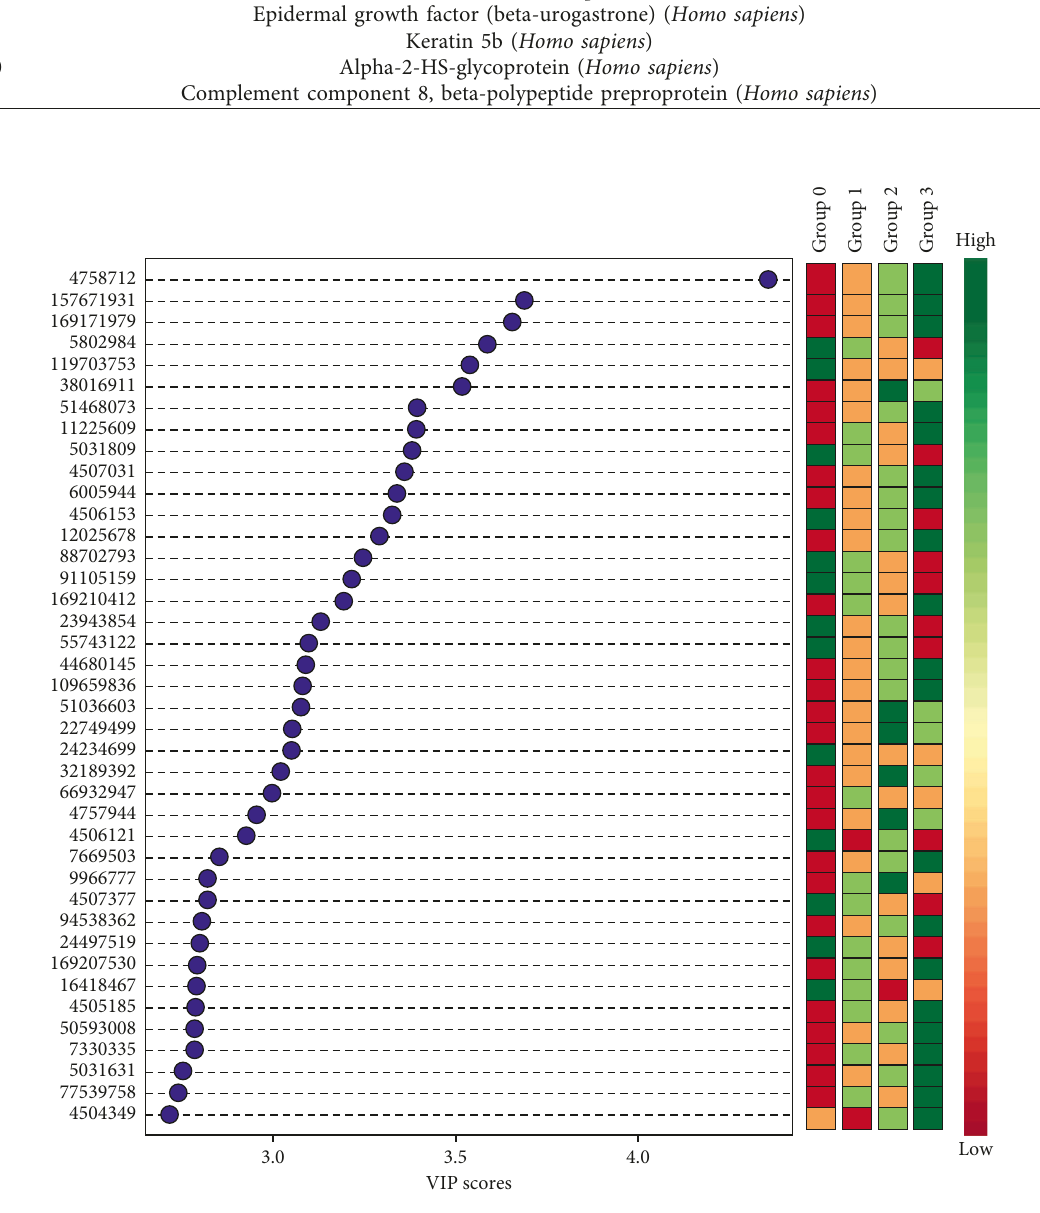
Figure 3: Variable importance in projection (VIP) plot: important features (analyzed NSAF scores of the proteins) identified by PLS-DA in a descending order of importance. The graph represents relative contribution of proteins to the variance between the cirrhotic subject and noncirrhotic subject control urine exosomes. High value of the VIP score indicates great contribution of the proteins to the group separation. The green and red boxes on the right indicate whether the protein concentration is increased (green) or decreased (red) in the exosome of the cirrhotic subject urine vs. noncirrhotic subject urine